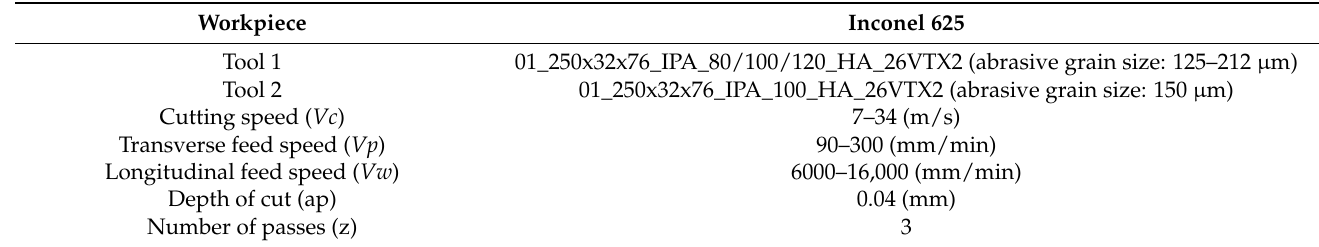
Table 2. Experimental conditions.